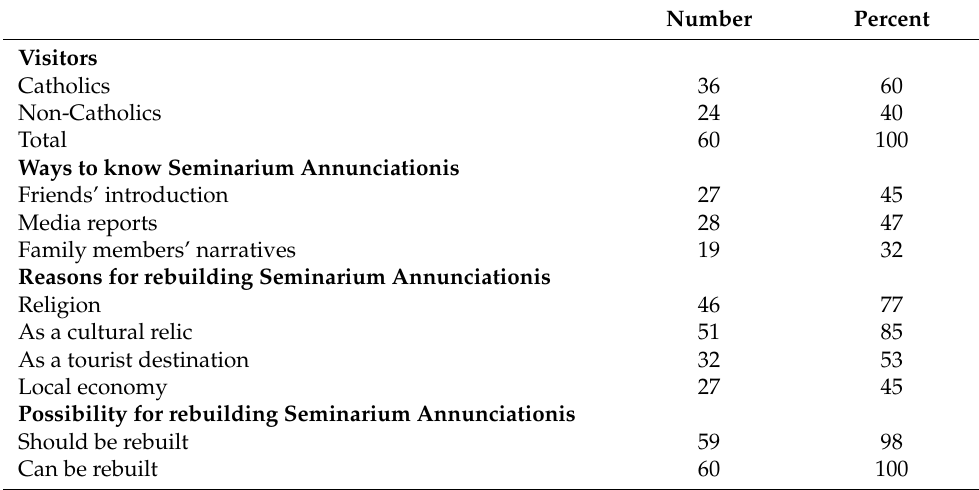
Table 2. Social Influence of Seminarium Annunciationis